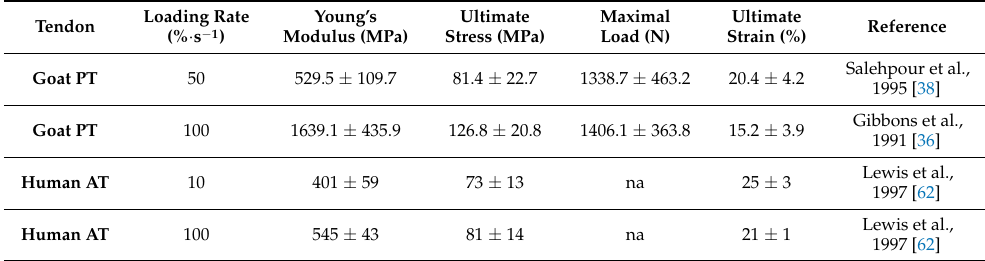
Table 5. Influence of strain rate on mechanical properties (%/s). ‘na’ indicates unavailable data.